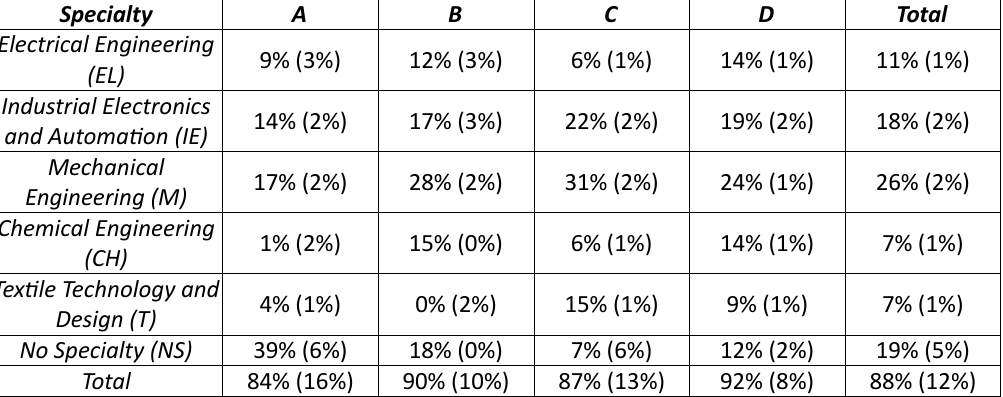
Table 5. Academic year 2013/14 – Percentages of the distributon of students passing the course (the percentage of students failing the course is indicated in parentheses), by group and